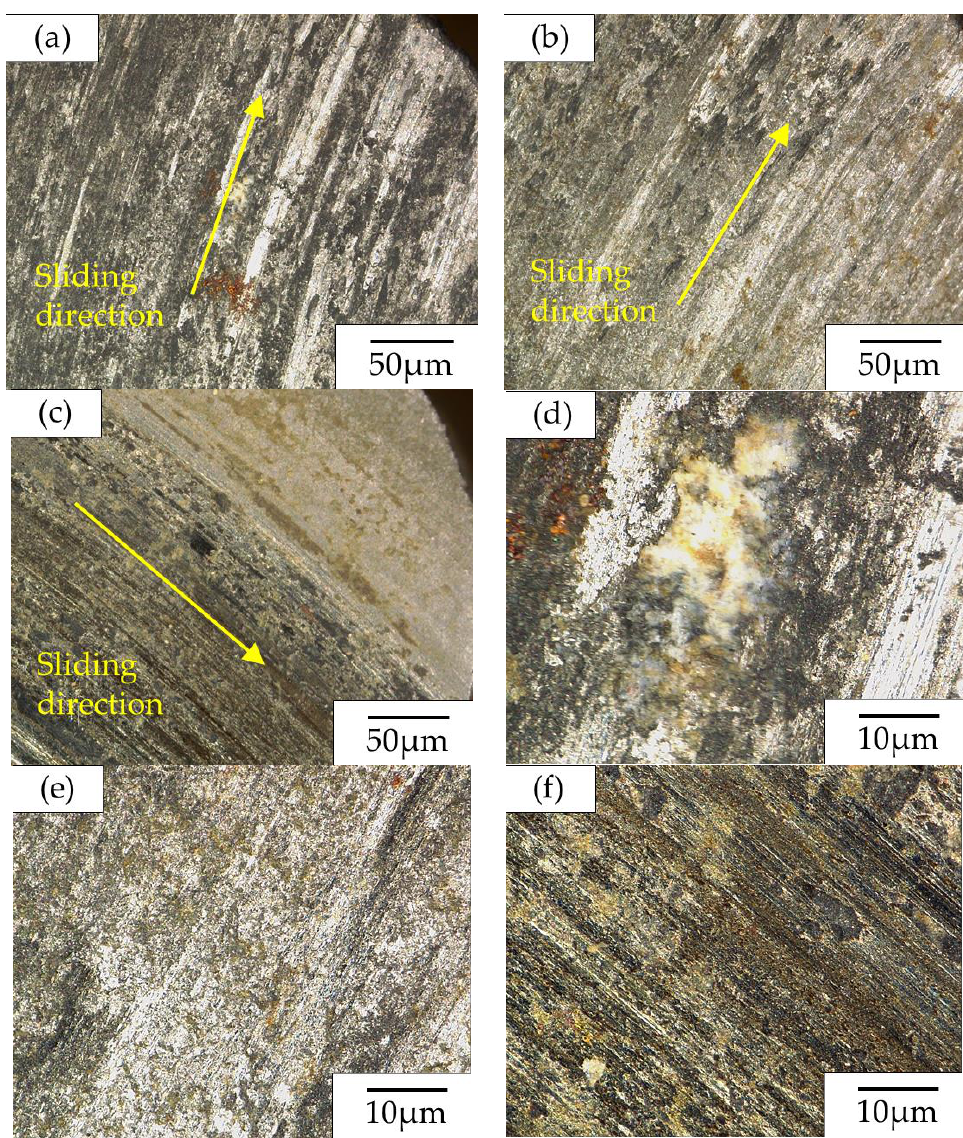
Figure 10. Micro morphologies of worn surfaces of the pin at different moistures (5 N, loam, 450 r/min): ( a , d ) moisture of 0%; ( b , e ) moisture of 10%; ( c , f ) moisture of